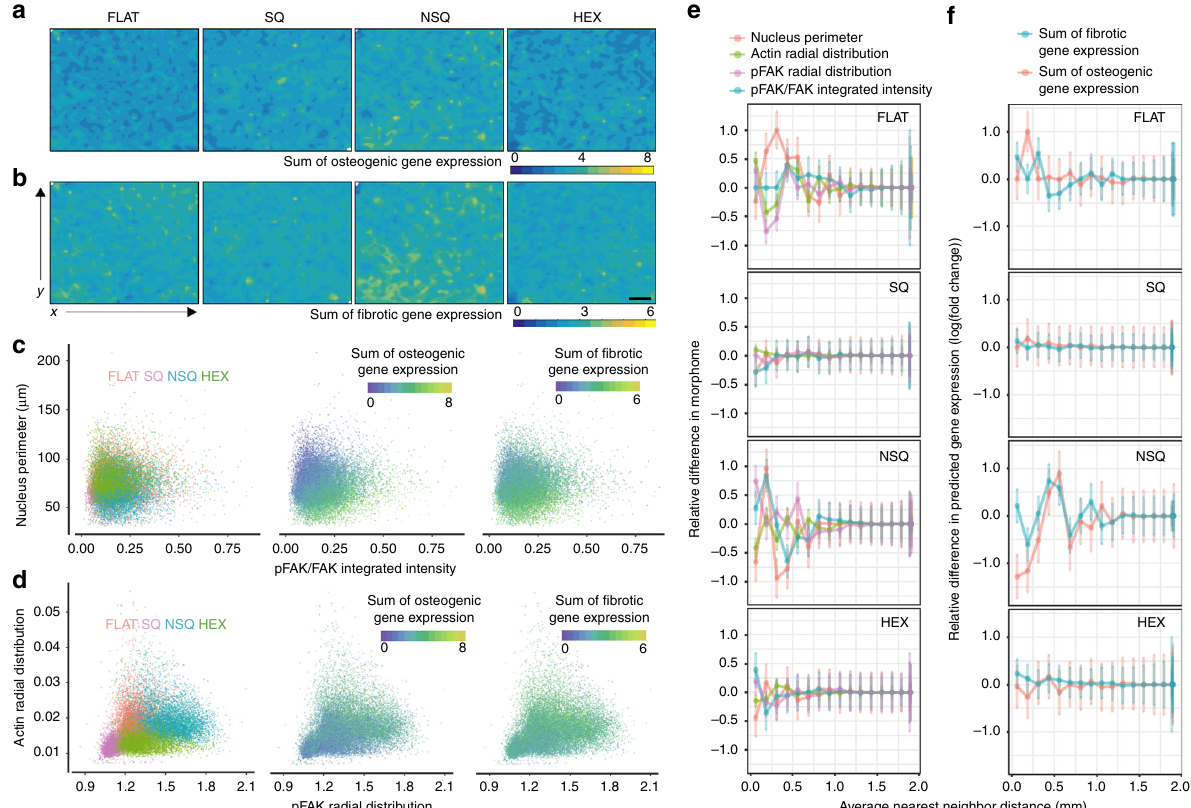
Fig. 6 Single-cell analysis of morphology and gene expression using the morphome. a , b Predicted response of a pre-osteoblast and fi broblast co-culture to nanotopography. Contour plots show the sum of predicted a osteogenic ( RUNX2, SP7, BGLAP, SPP1 ) and b fi brotic ( TGFB1I1, COL3, ELN ) gene expression for individual cells on FLAT, SQ, NSQ, and HEX topographies. Pre-osteoblast and fi broblast cells were co-cultured on FLAT, SQ, NSQ, and HEX nanotopographies for 2 days, and their morphome obtained from the entire nanotopography surface. The newly collected morphome was then used as input in the linear regression model (shown in Fig. 5a) to predict gene expression. x and y axes of each contour plot shows are spatial coordinates on the nanotopogrpahy substrate, while the color of the contour represents the level of summed gene expression. Scale bar = 100 µ m. c , d Morphology and gene expression at the single-cell level is provided by the morphome. Each dot in the scatterplot denotes a single-cell. Nanotopographies are color coded, with FLAT denoted in pink, SQ denoted in purple, NSQ denoted in blue and HEX denoted in green. e , f Cell – cell interaction altered by nanotopography. The average changes in e cell morphology and f gene expression between two neighboring cells separated by a speci fi ed distance was measured and normalized to the maximum observed change. Data are presented as mean ± standard deviation and reported as a function of distance between two cells binned every 125 µ m. N ≥ 5000 cells per topography from one independent